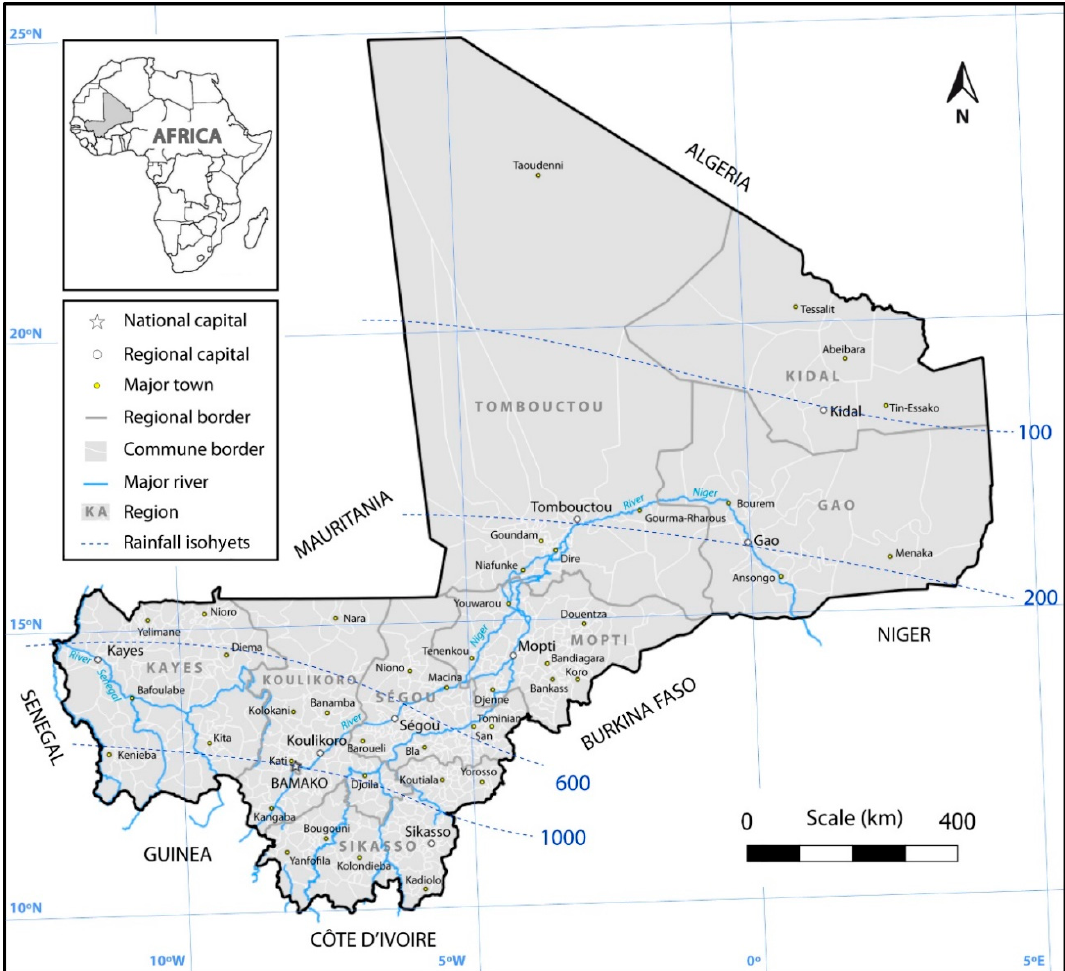
Figure 1. Geographical setting. The Republic of Mali showing regional and communal divisions, major towns and the main fluvial network.